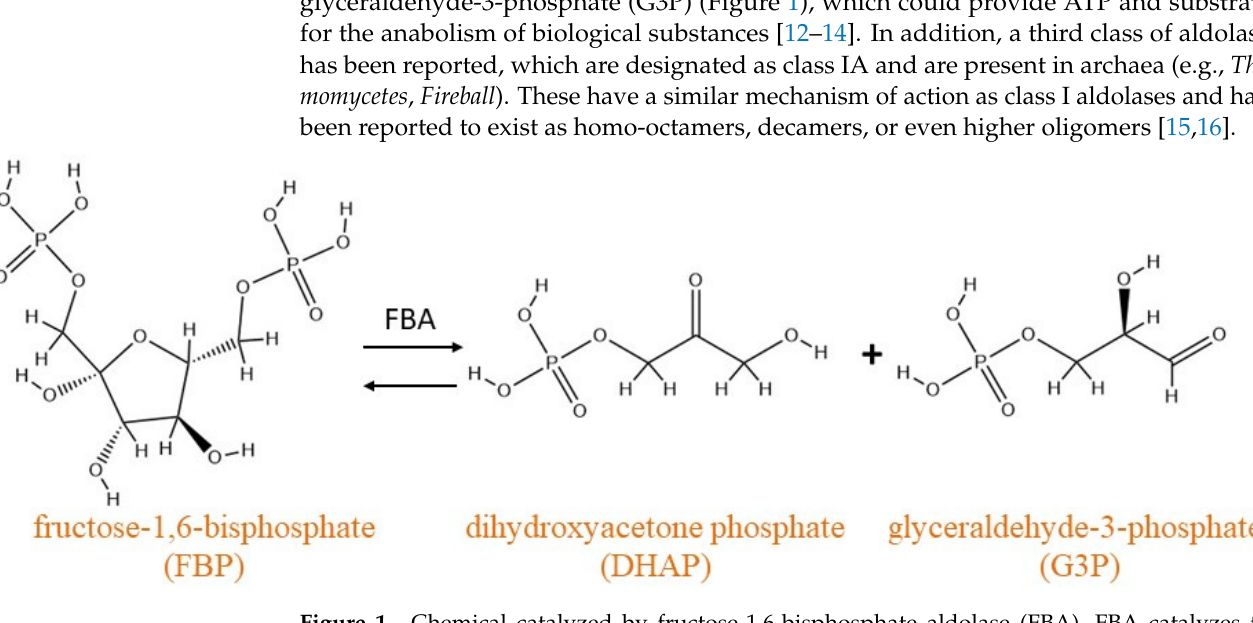
Figure 1. Chemical catalyzed by fructose-1,6-bisphosphate aldolase (FBA). FBA catalyzes the cleavage of fructose 1,6-diphosphate (FBP) to dihydroxyacetone phosphate (DHAP) and glycerol 3-phosphate (G3P).